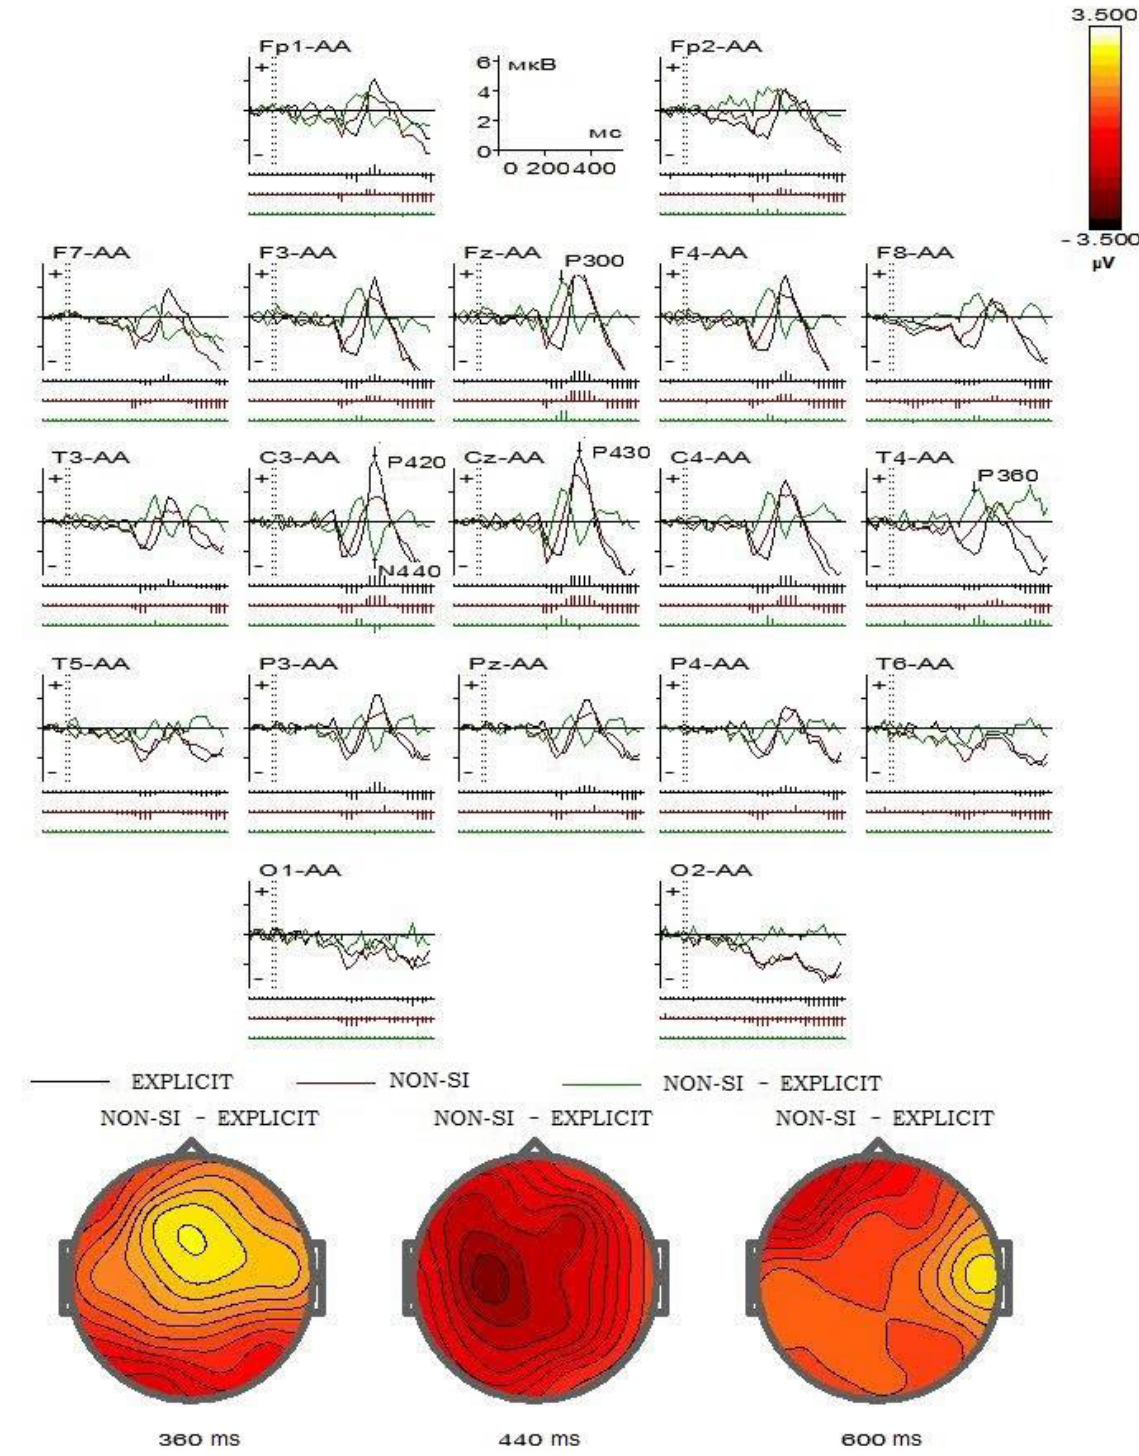
Figure 3. ERP on explicit SI words and non-SI words in auditory modality for all 19 channels. Colorful figure below shows topograms of differences on surface of head in microvolts according to the color scale in upper right corner of figure for three time frames of 360, 440, and 600